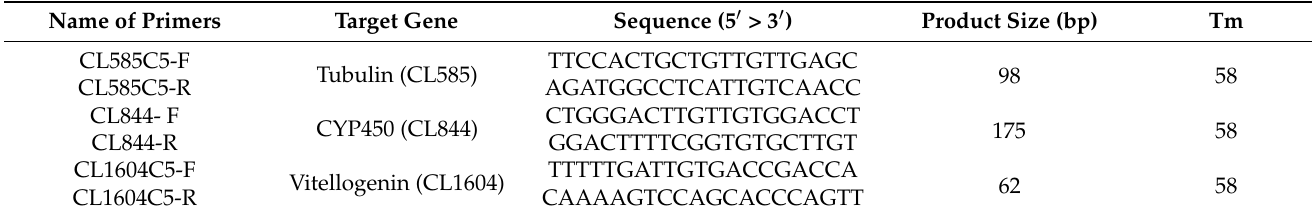
Table 1. Primer sequences and characteristics of the primers used for qRT-PCR.